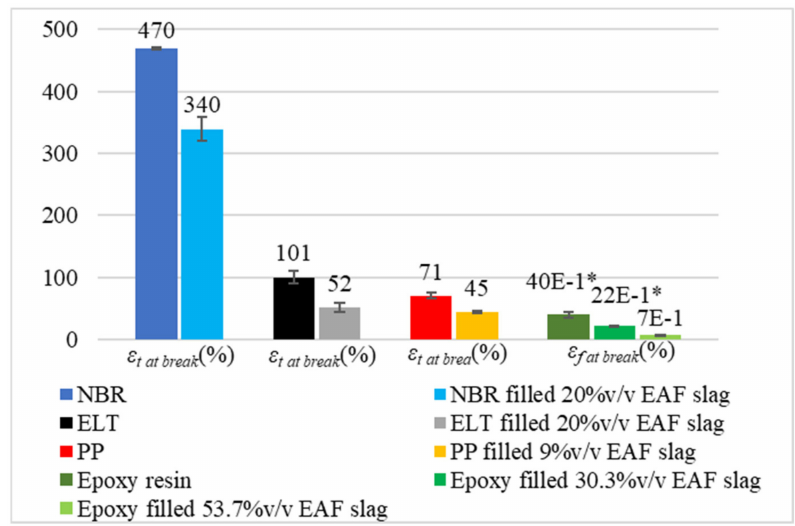
Figure 5. Influence of EAF slag as filler for NBR, ELT, PP, and epoxy resin matrix on strain at break. (*) Neat epoxy and epoxy filled at 30.3% v / v yield gradually above the peak; the considered strain at break is the strain at yielding